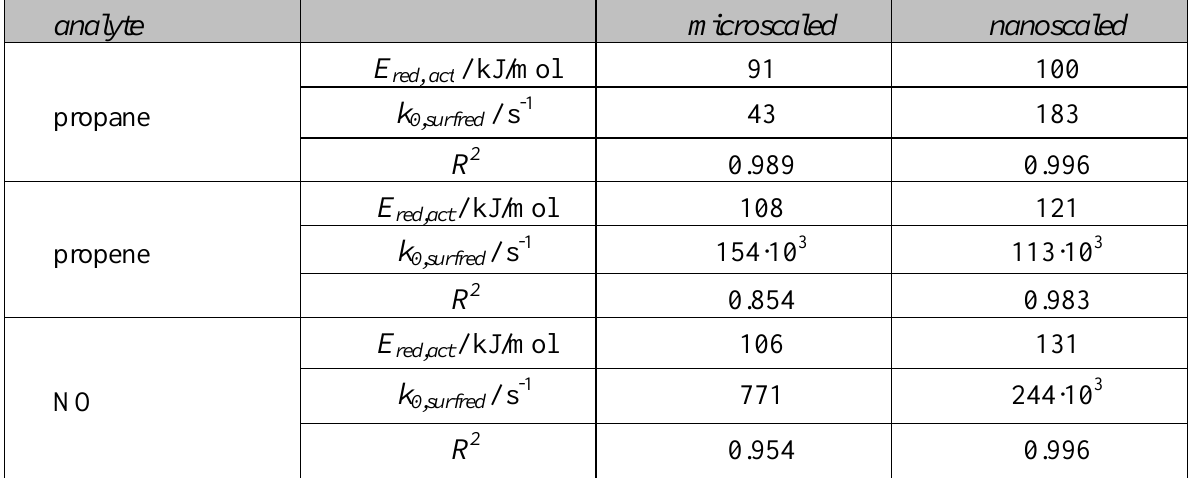
Table 3. Parameters used for fitting the temperature-dependent propane, propene, and NO response of different SrTi measure for the goodness of